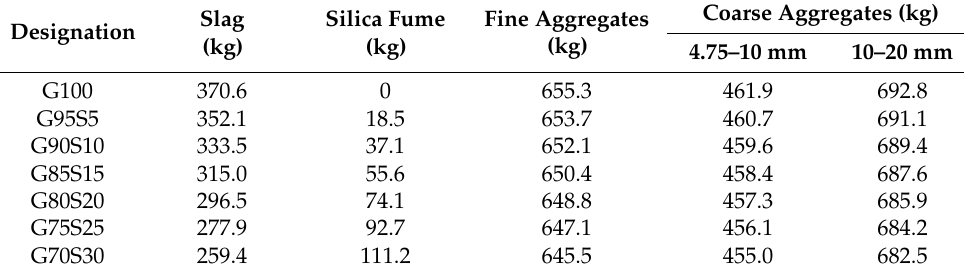
Table 2. GPC ingredients proportioning for 1 m 3 of the mix.